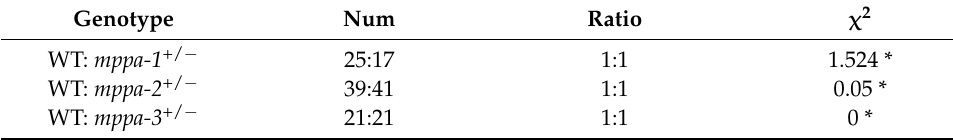
Table 1. mppa +/ − T 3 Segregation.